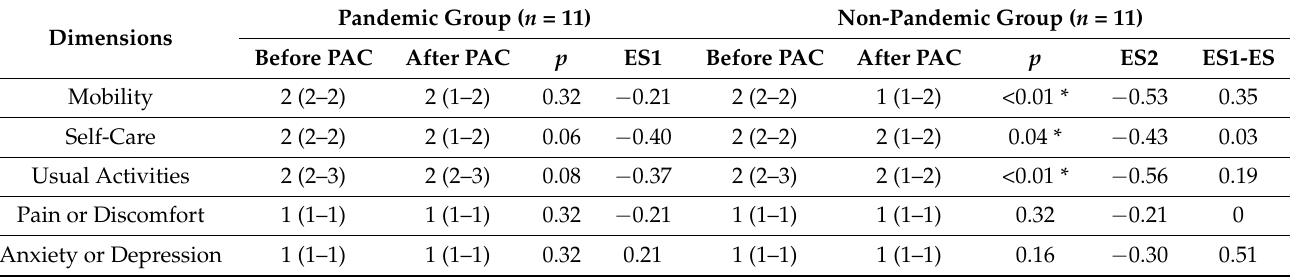
Table 4. The five dimensions in EQ-5D before and after PAC program: comparison between different groups.